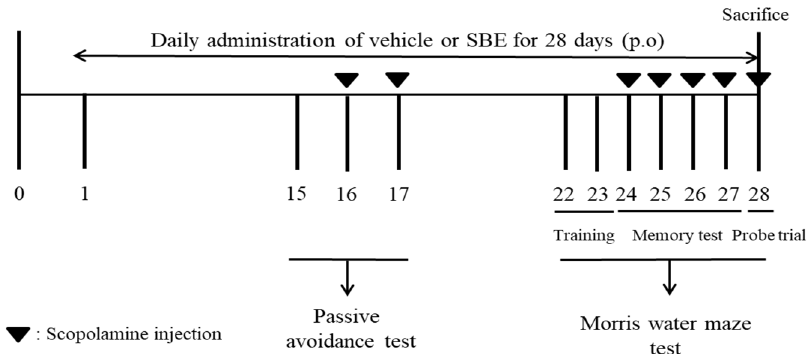
Figure 1. Experiment process of scopolamine-treated memory deficiency in mice.